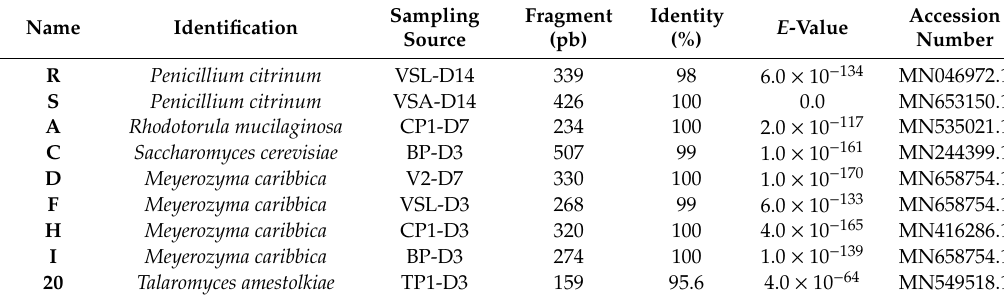
Table 2. Identification of fungal